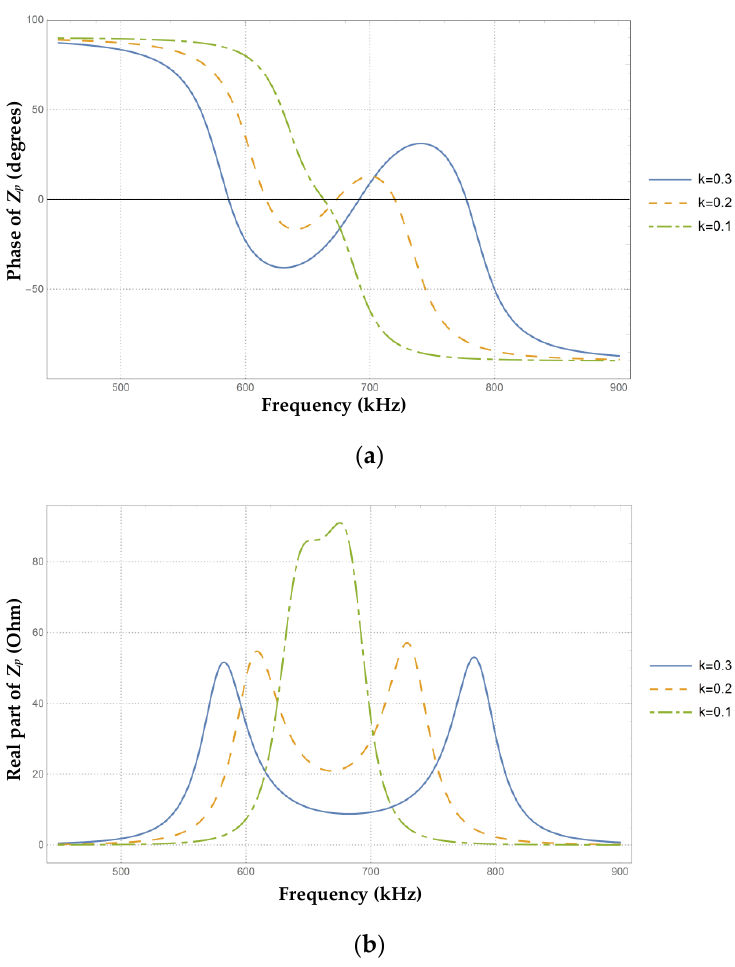
Figure 5. The impedance characteristic of Zp versus frequency: ( a ) phase angle; ( b ) real part. According to Equation (14), the bifurcation coupling coefficient k b is about 0.1312 and the free resonant frequency f 0 is 660 kHz for this system. As illustrated in Figure 5a, there exist three ZPA frequencies in the bifurcation region (i.e., k = 0.3 or k = 0.2). The middle bifurcation frequency is near the free resonant frequency f 0 , while the other two ZPA frequencies are distributed at both sides of the middle bifurcation frequency f m . Furthermore, the deviation between the middle bifurcation frequency f m and the free resonant frequency f 0 become larger as the coupling coefficient increases, as does the distance between the other two ZPA frequencies. In the bifurcation-free region (i.e., k = 0.1), there is only one ZPA frequency f m near the free resonant frequency f 0 .